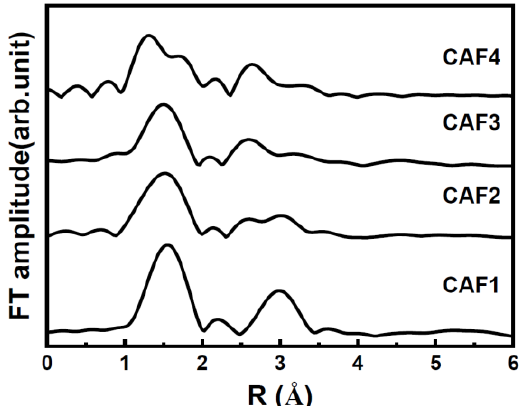
Figure 6. Fe K-edge EXAFS spectra for Ca – Al – Fe LDHs with various Ca/Al/Fe